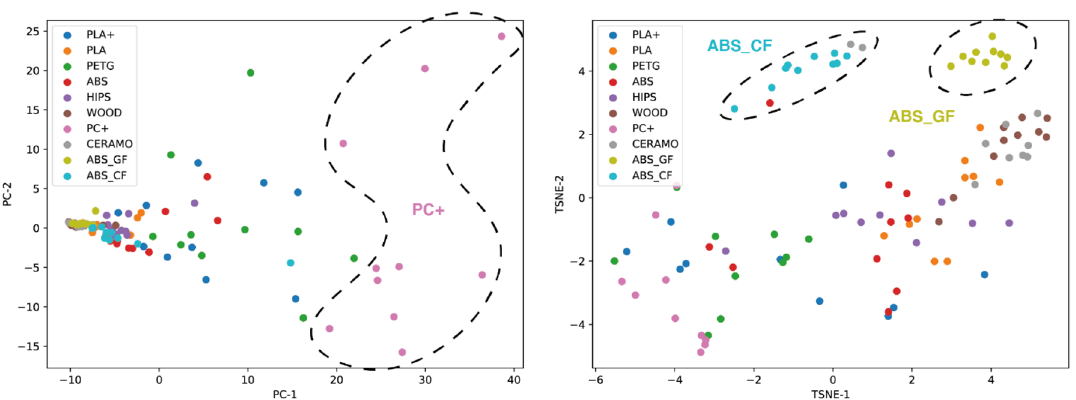
Figure 4. Overview of information available from thermographic videos. ( A ) describes thermographic plots and maximum heating temperatures. ( B ) Shows the distribution of maximum heating temperatures for different materials. ( C ) Observed relationships between thermographic and mechanical data. ( D ) Shows the use of entire curves for material